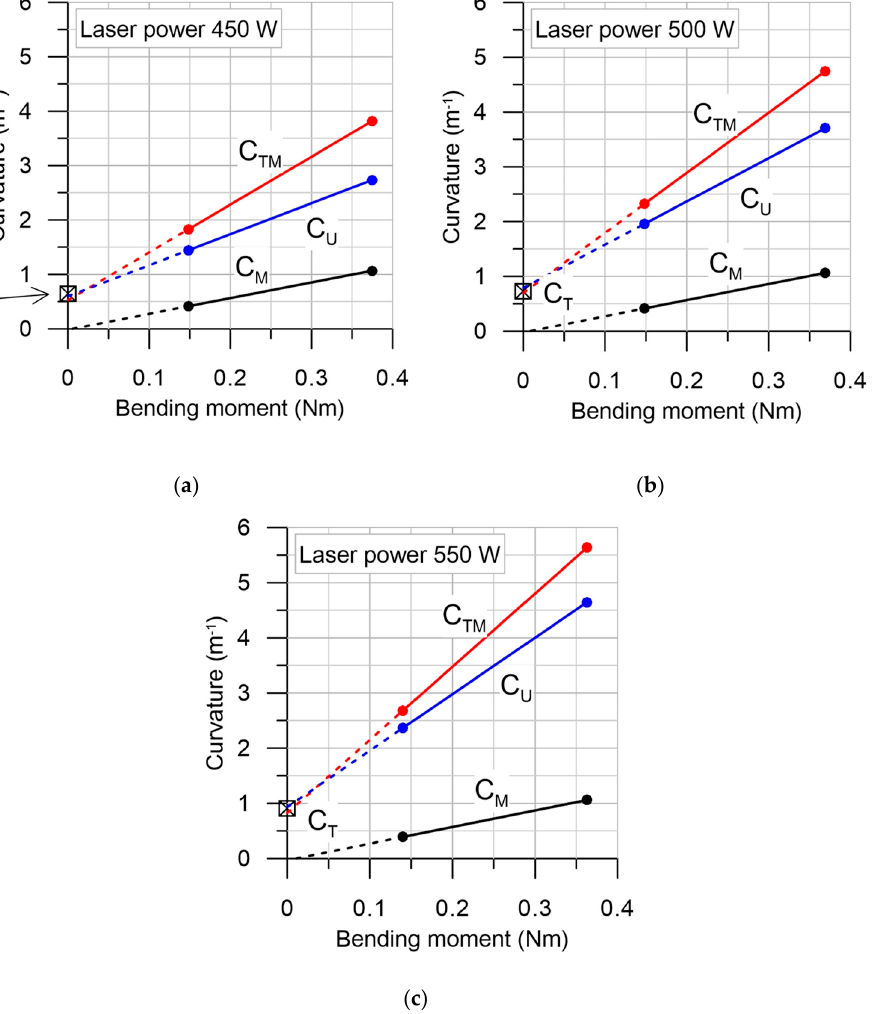
Figure 5. Dependence of beam curvature on bending moment for laser beam power: ( a ) 450 W; ( b ) 500 W; ( c ) 550 W. Free ‐ end load force F 3.04 N.